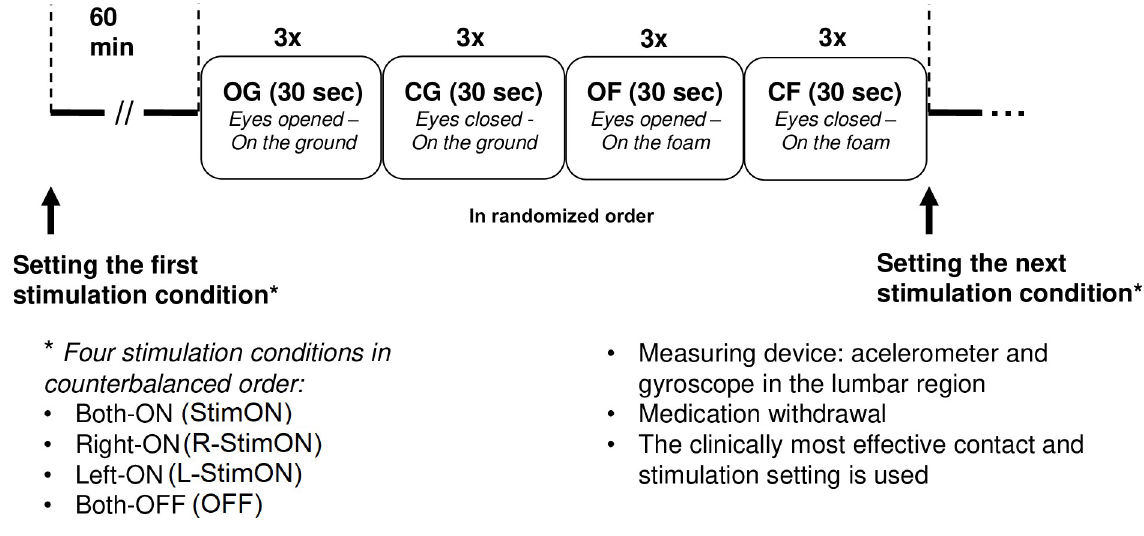
Fig 1. Measurement